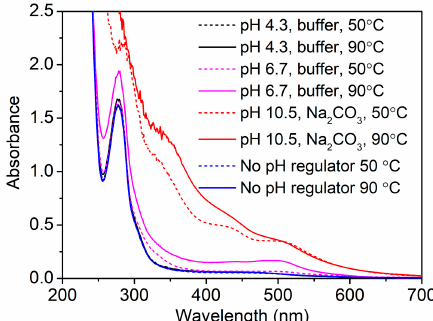
Figure 2. UV–vis absorption spectra of GSE solution at different pHs and two temperatures (GSE concentration, 0.1 g/L).